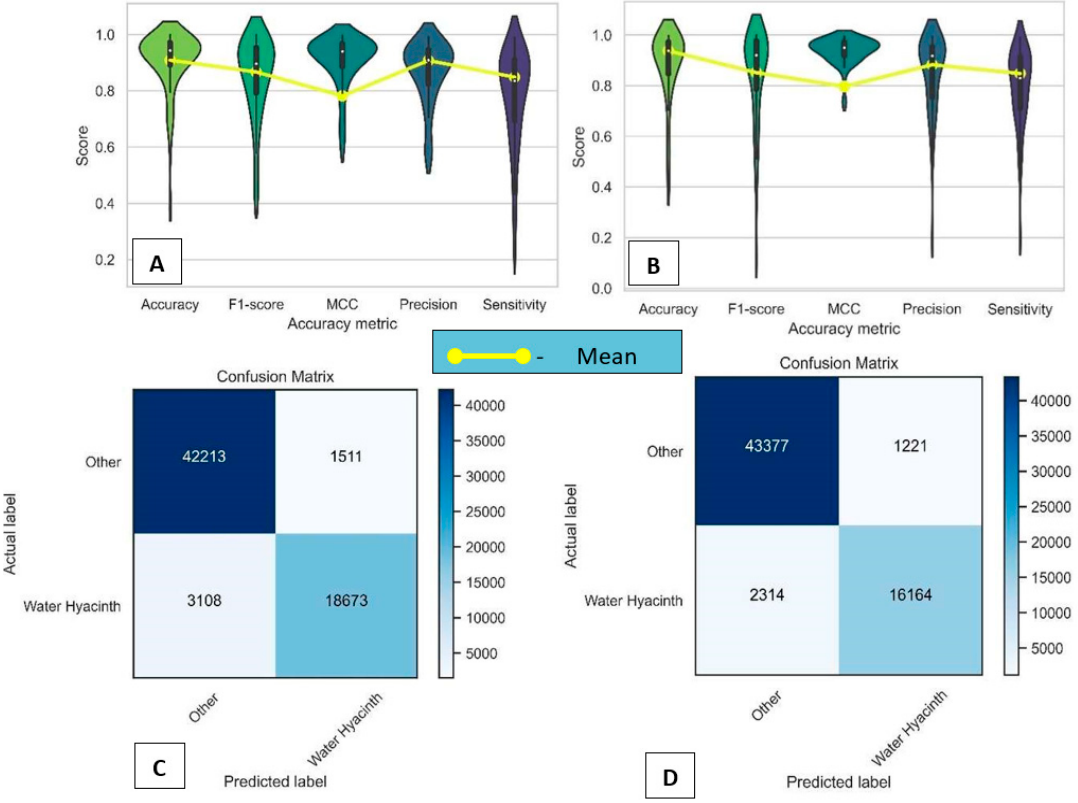
Figure 8. Slightly lower accuracy scores for water hyacinth discrimination when using all 64 features (( A ), listed in Table 1) than when using the top eight, most important features ( B ). Considering the results of using all 64 features ( A , C ) and the top eight features ( B , D ), the MCC shows the lowest variation among the five metrics in both scenarios. This points towards its reduced sensitivity to the negative class imbalance evident in the summed confusion matrices ( C , D ). There is also a false positive ratio of 2:1 for water hyacinth and other aquatic vegetation, respectively.